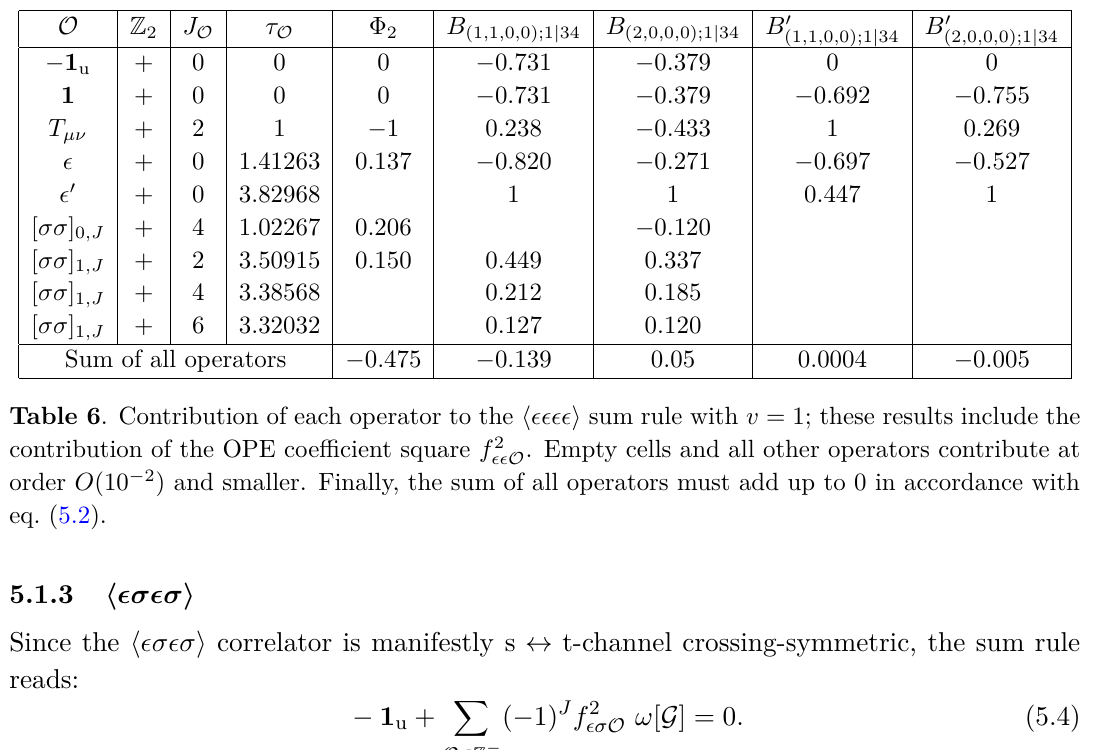
Figure 6 . Action of the B k ;1 and Φ 2 functional on exchanged operators in the OPE of the h (cid:15)(cid:15)(cid:15)(cid:15) i correlator. The “even” family in the legend corresponds to other stable Z even operators. The 2 functional acting on the [ σσ ] and low twist [ (cid:15)(cid:15) ] families are defined by analytic continuation. 0 ,J 0 ,J For the Φ functional, the projection lifts the negativity of the [ (cid:15)(cid:15) ] family at the cost of losing 2 0 ,J convergence of the [ σσ ] family for higher spin operators. 0 ,J